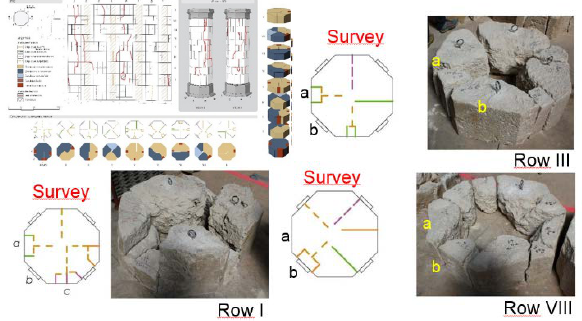
Figure 9. Pillar n. 12. The drawings made during